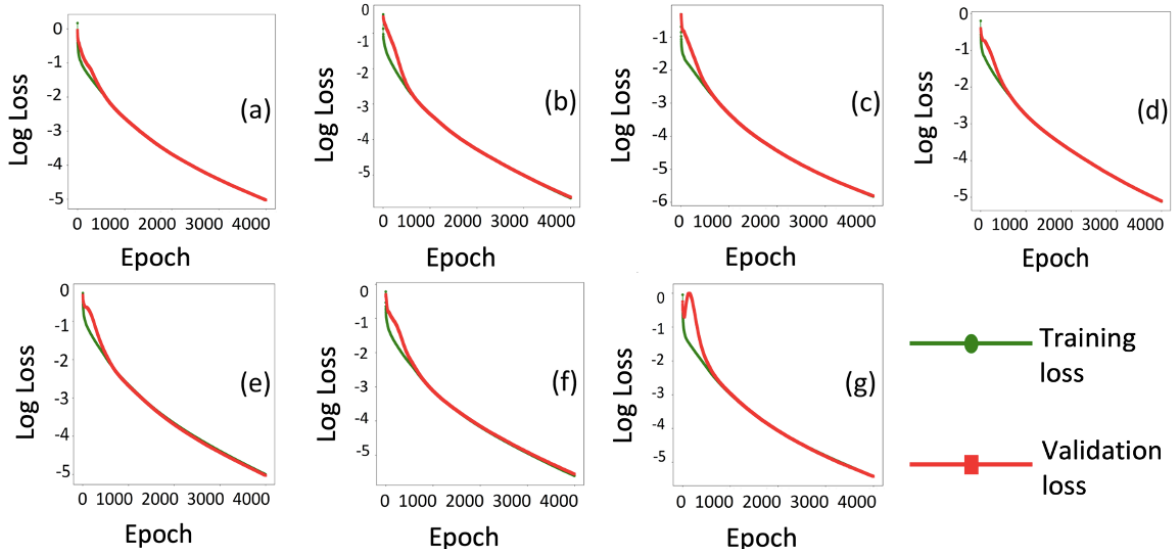
Figure 12. Training and validation log losses vs. number of iterations for the proposed model ( a ) class 1; ( b ) class 2; ( c ) class 3; ( d ) class 4; ( e ) class 5; ( f ) class 6; ( g ) class